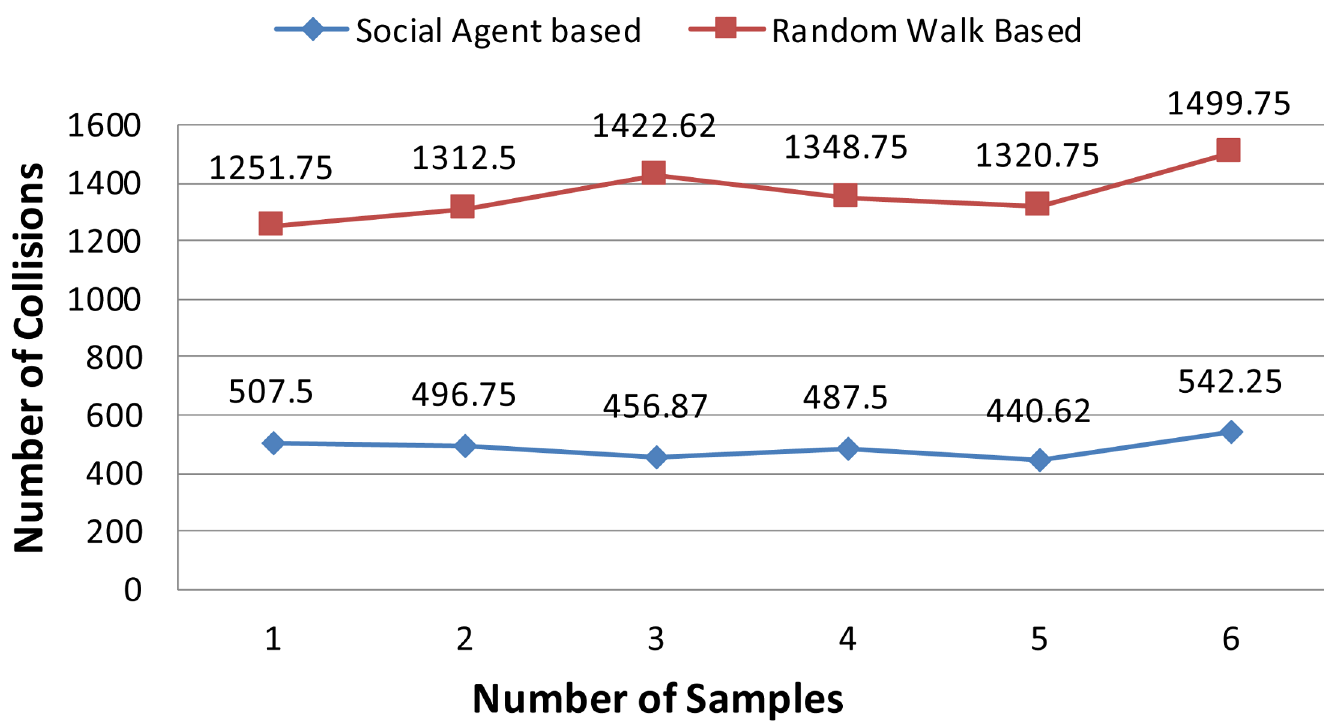
Fig 7. Graphical representation of test case 4.